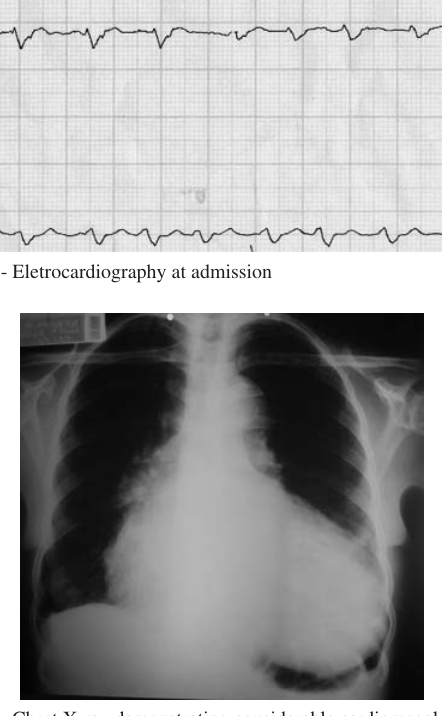
Figure 2 - Chest X-ray demonstrating considerable cardiomegaly